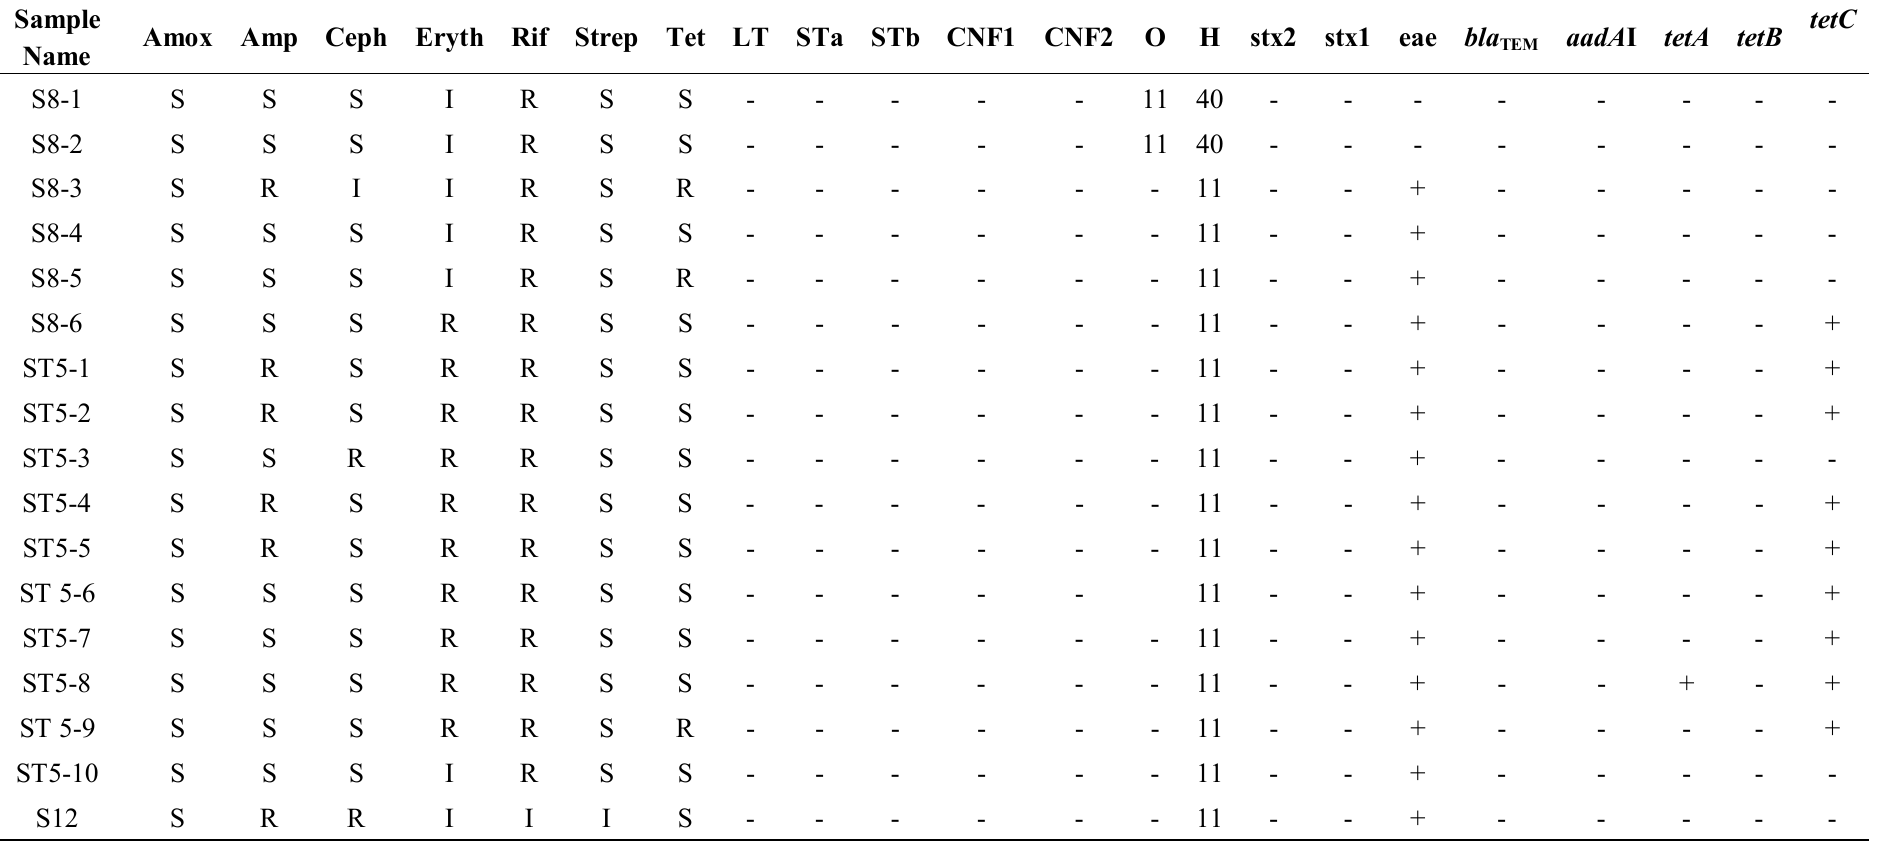
Table 2. Antimicrobial susceptibility, genetic variations, and resistant genotypes of selected isolates of presumptive pathogenic E. coli . *